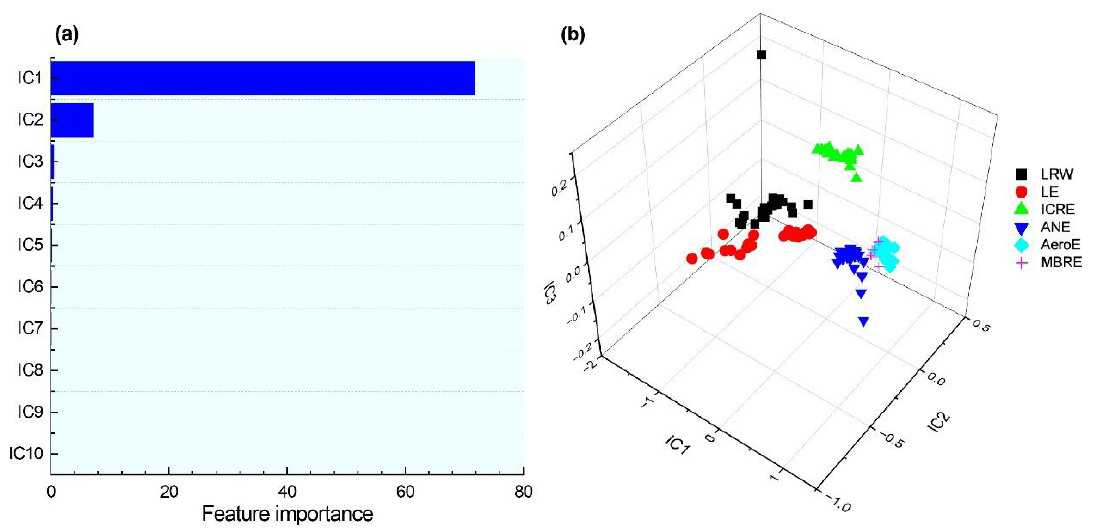
Figure 5. EN data reduction based on ISOMAP: ( a ) ICs ordered according the eigenvalues, ( b ) sample distributions based on the first three ICs.